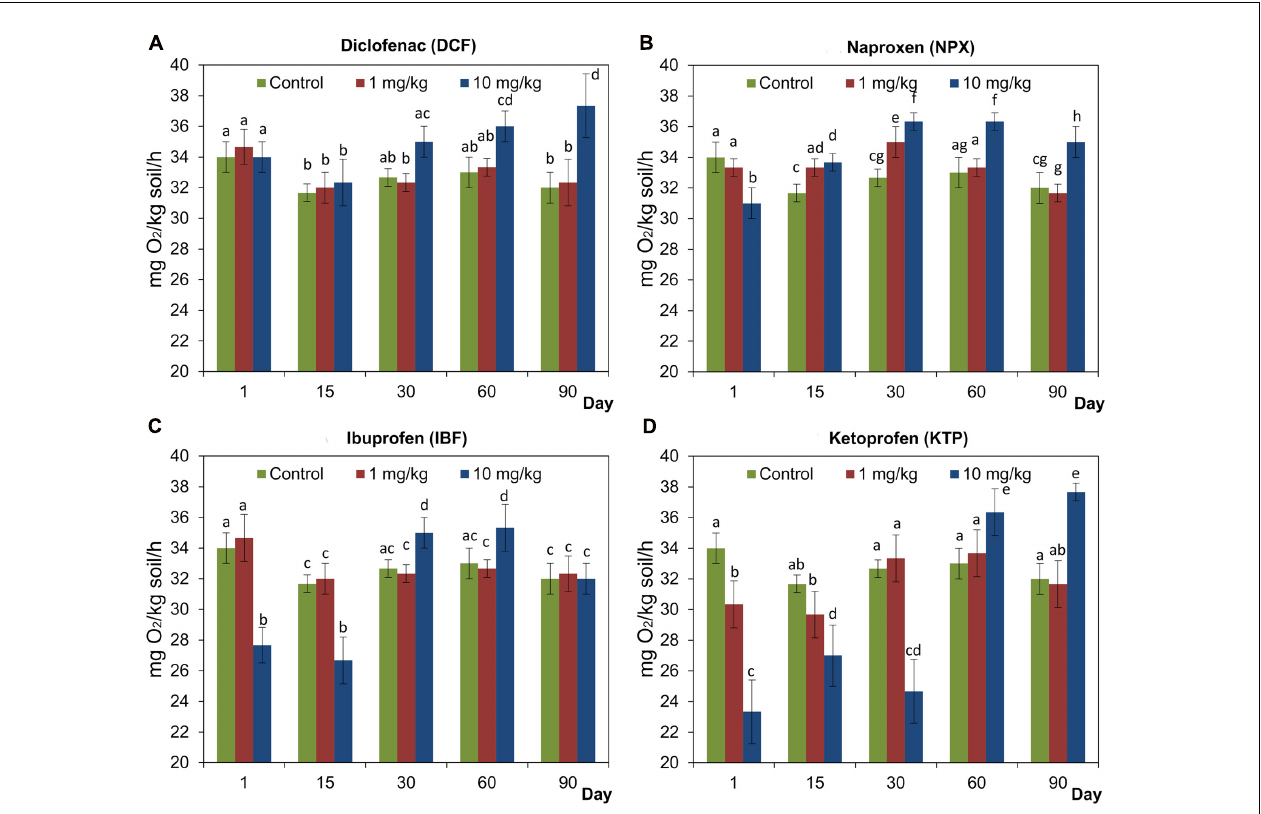
FIGURE 2 | Substrate-induced respiration (SIR) in the control soil and soil treated with diclofenac (A) , naproxen (B) , ibuprofen (C) , and ketoprofen (D) at concentrations of 1 and 10 mg/kg soil during the 90-day experiment. The data presented are the means and standard deviations of three replicates and are expressed as mg O 2 /kg soil/h. Different letters (within each drug) indicate significant differences ( P < 0.005, LSD test) related to the effects of concentration and